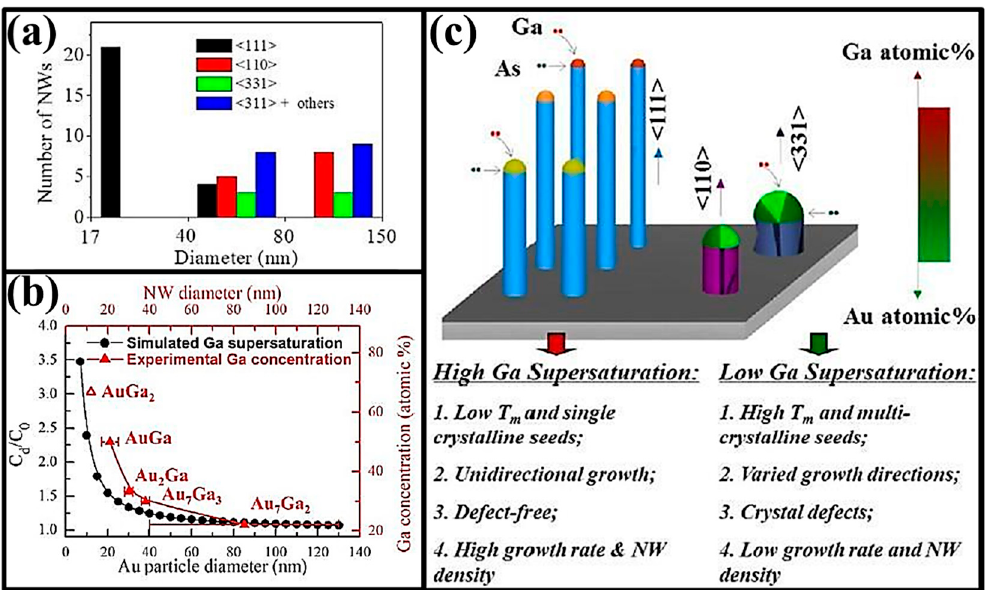
Figure 5. Supersaturation-controlled growth of GaAs NWs. ( a ) Growth direction statistics of grown GaAs NWs. ( b ) Simulation of the Ga supersaturation in Au nanoparticles with various diameters (black line) and the experimental results of catalytic Ga concentration with different NW diameters (red line). ( c ) The schematic illustration of GaAs NW growth rate, density, orientation, and crystal phase change with Ga supersaturation in Au catalyst with different diameters. Adapted with permission from [94].